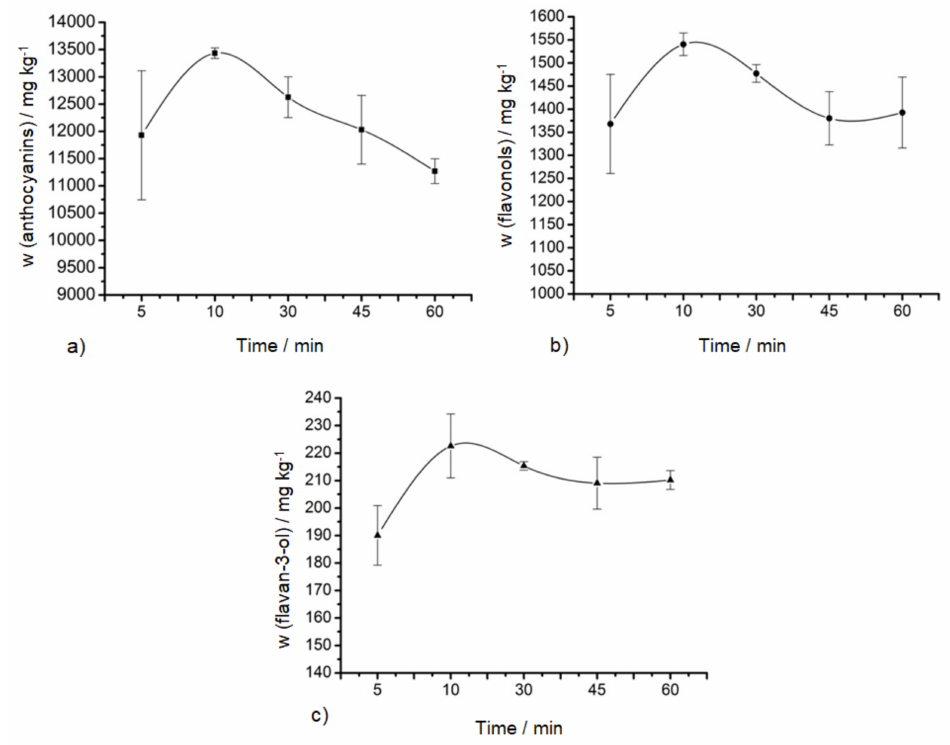
Figure 2. Influence of the extraction time on the contents of ( a ) anthocyanin, ( b ) flavonol, and ( c )